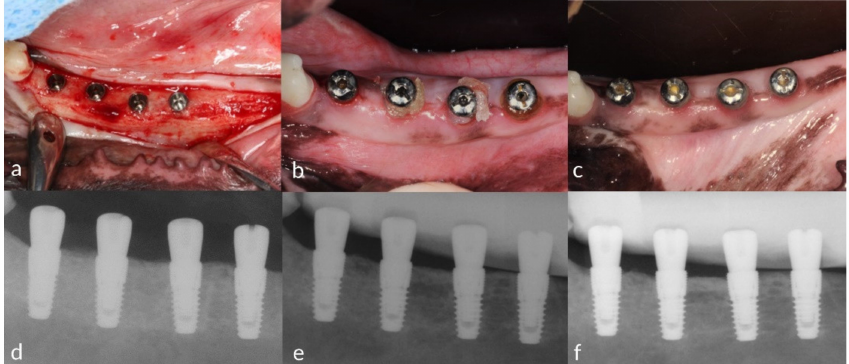
Figure 2. Clinical photographs and radiographs—Clinical photographs taken at ( a ) the surgery (S0), ( b ) the first drug administration (baseline, T1) and ( c ) 8 weeks after the baseline (T3). Peri-apical radiographs taken at ( d ) the surgery, ( e ) the baseline and ( f ) 8 weeks after the